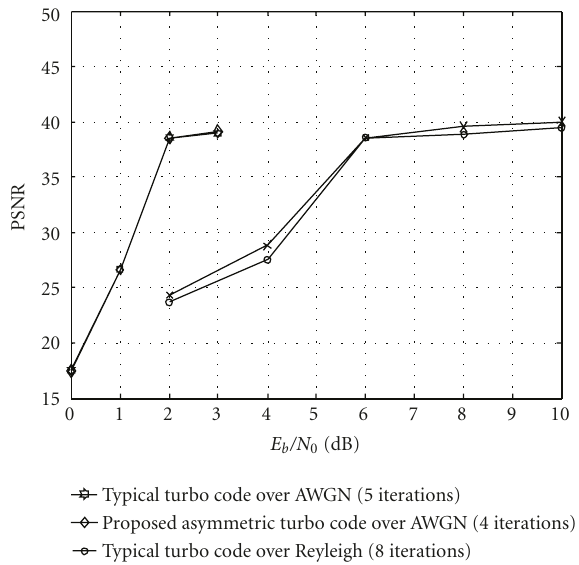
Figure 18: Comparison of decoded image quality (in PSNR) of typ- ical turbo code and proposed asymmetric turbo code